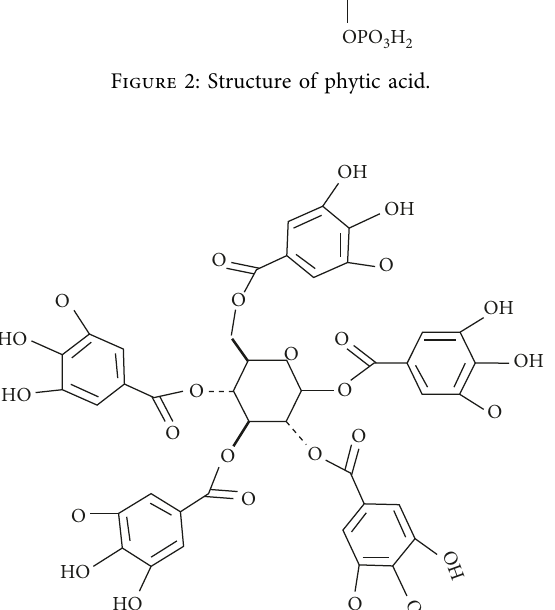
Figure 3: Chemical structure of tannin.